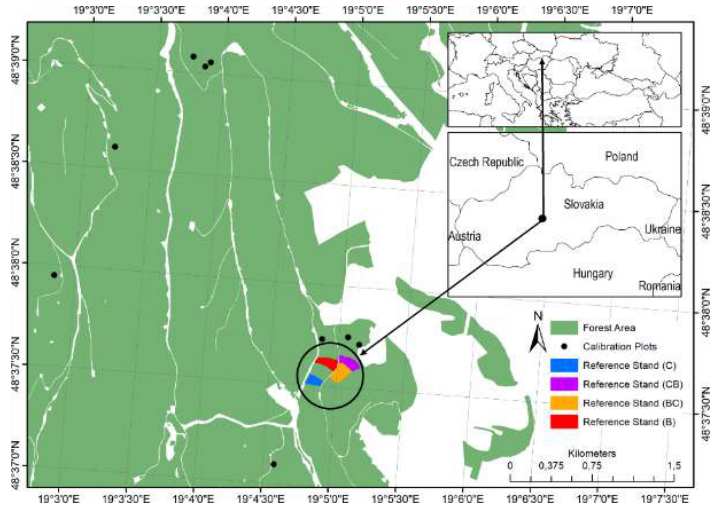
Figure 1. Location of the study area with position of nine calibration plots (black points) and four reference stands (Blue polygon: Dominance of conifers; purple and orange polygon: Mix of conifers and broadleaves; red polygon: Dominance of broadleaves).